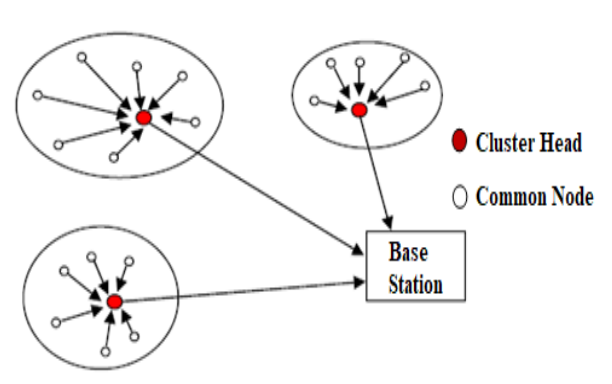
Figure 1. LEACH protocol configurations in real- time